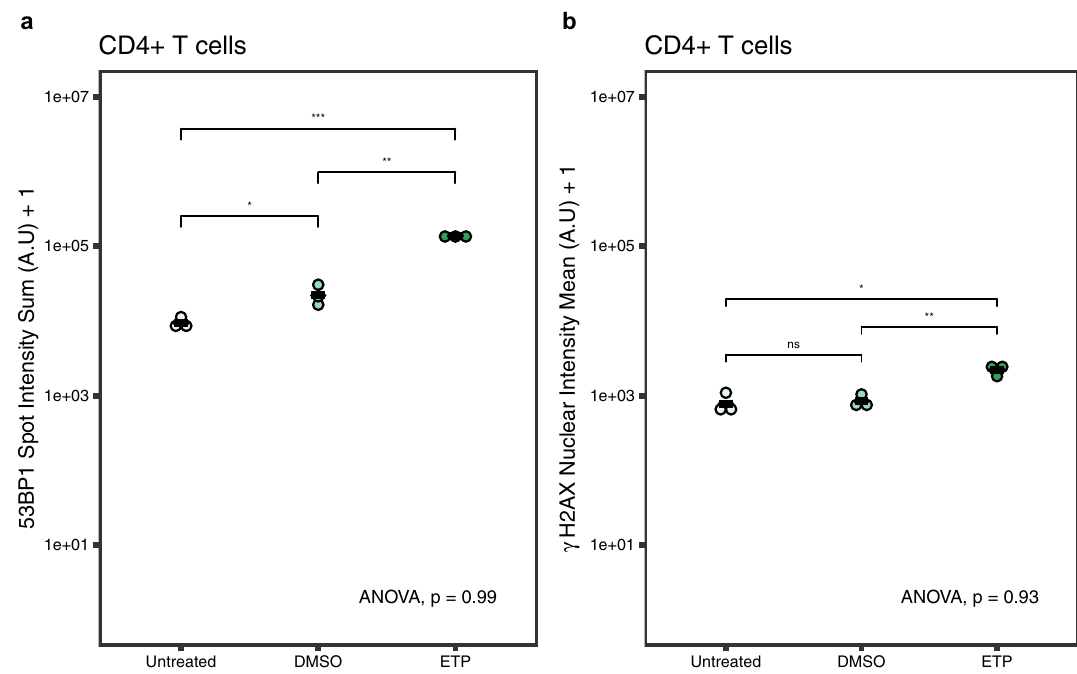
Figure 4. Inter-assay variability. ( a ) Distribution of 53BP1 sum spot intensity in untreated, DMSO-treated, and ETP-treated CD4 + T cells from the same donor. Each dot represents the mean value of a treatment replicate. Black line represents mean integrated 53BP1 spot intensity and γ-H2AX mean nuclear intensity *: p < 0.05, **: p < 0.01, ***: p < 0.001. ANOVA = 0.99. (b) Distribution of γ-H2AX nuclear intensity in untreated, DMSO- treated, and ETP-treated CD4 + T cells from the same donor. Each dot represents the mean γ-H2AX nuclear intensity for each treatment replicate. Black line represents the mean γ-H2AX nuclear intensity for all three replicates. *: p < 0.05, ns: p > 0.05. ANOVA = 0.93. Statistics calculated using Mann–Whitney-Wilcoxon test and one-way ANOVA. N = 1776–14,059 cells per sample. ANOVA values represent the variance between replicates for each treatment